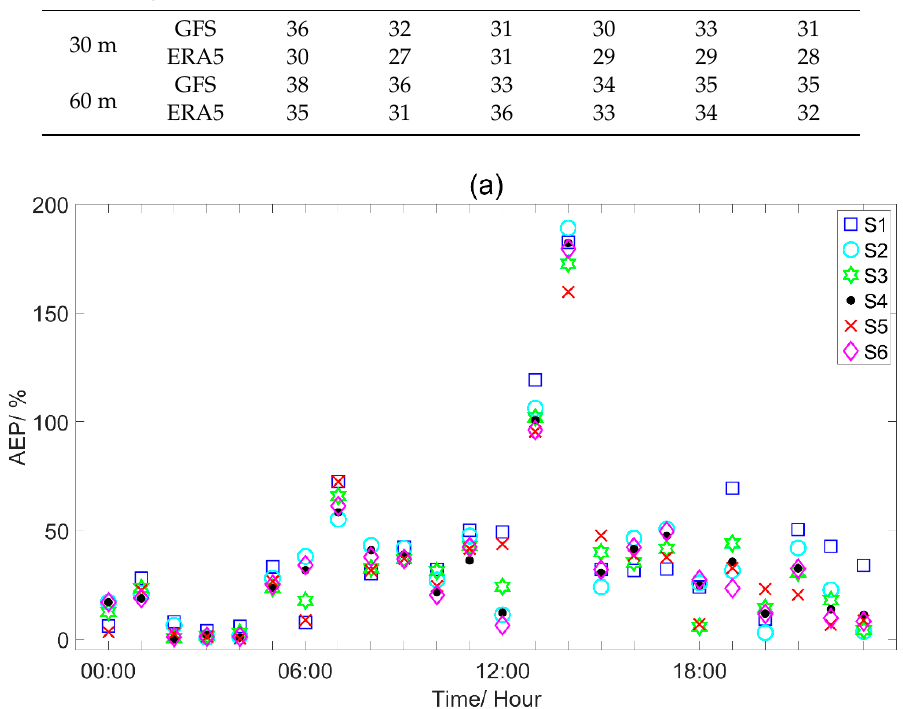
differences between different simulations more clearly, the comparison of averaged AEPs are shown in Table 7. in Table 7.